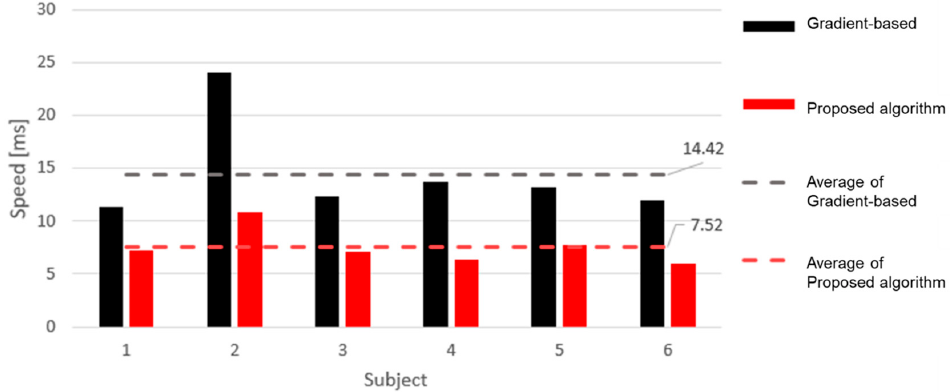
Figure 8. Calculation speed of the gradient-based detection algorithm and the proposed peak detection algorithm.